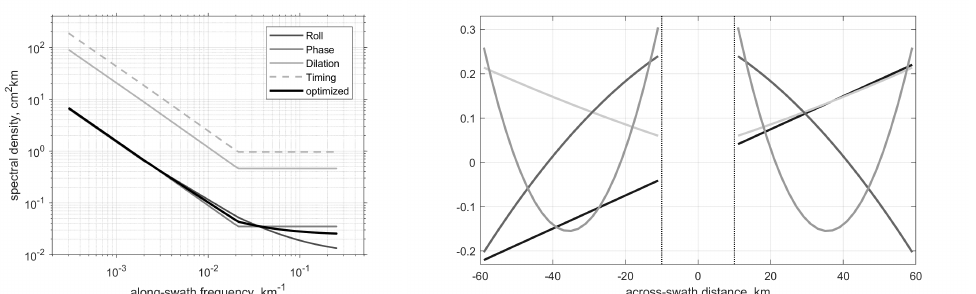
Figure 1. ( Left ): Square roots of the four GOE spectral components (gray lines) and their optimized approximation (black). The spectra of baseline dilation and timing errors are reduced by an order in magnitude for better viewing. ( Right ) orthogonal eigenmodes F x of the across-swath GOE covariance